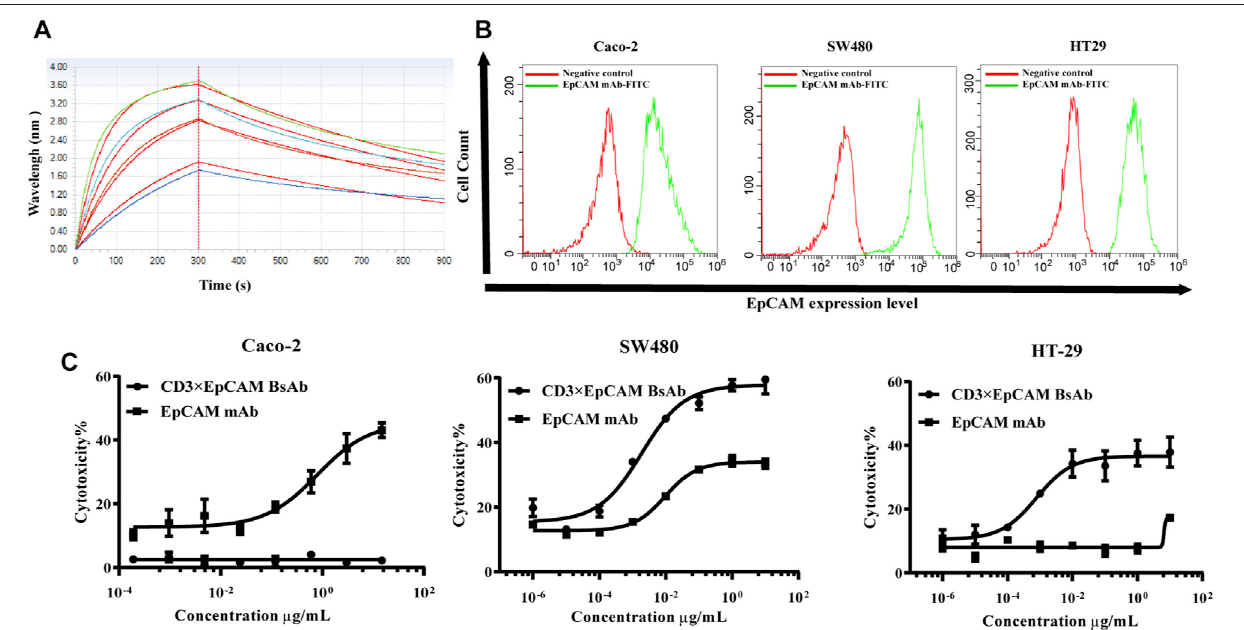
FIGURE 3 | Binding activity to EpCAM and in vitro cytotoxicity analysis of CD3×EpCAM BsAb. (A) Af fi nity analysis of CD3×EpCAM BsAb to EpCAM detected by BLI. (B) Expression of EpCAM on different cell lines detected by fl ow cytometry. (C) In vitro cytotoxicity assay of CD3×EpCAM bispeci fi c antibody using LDH release